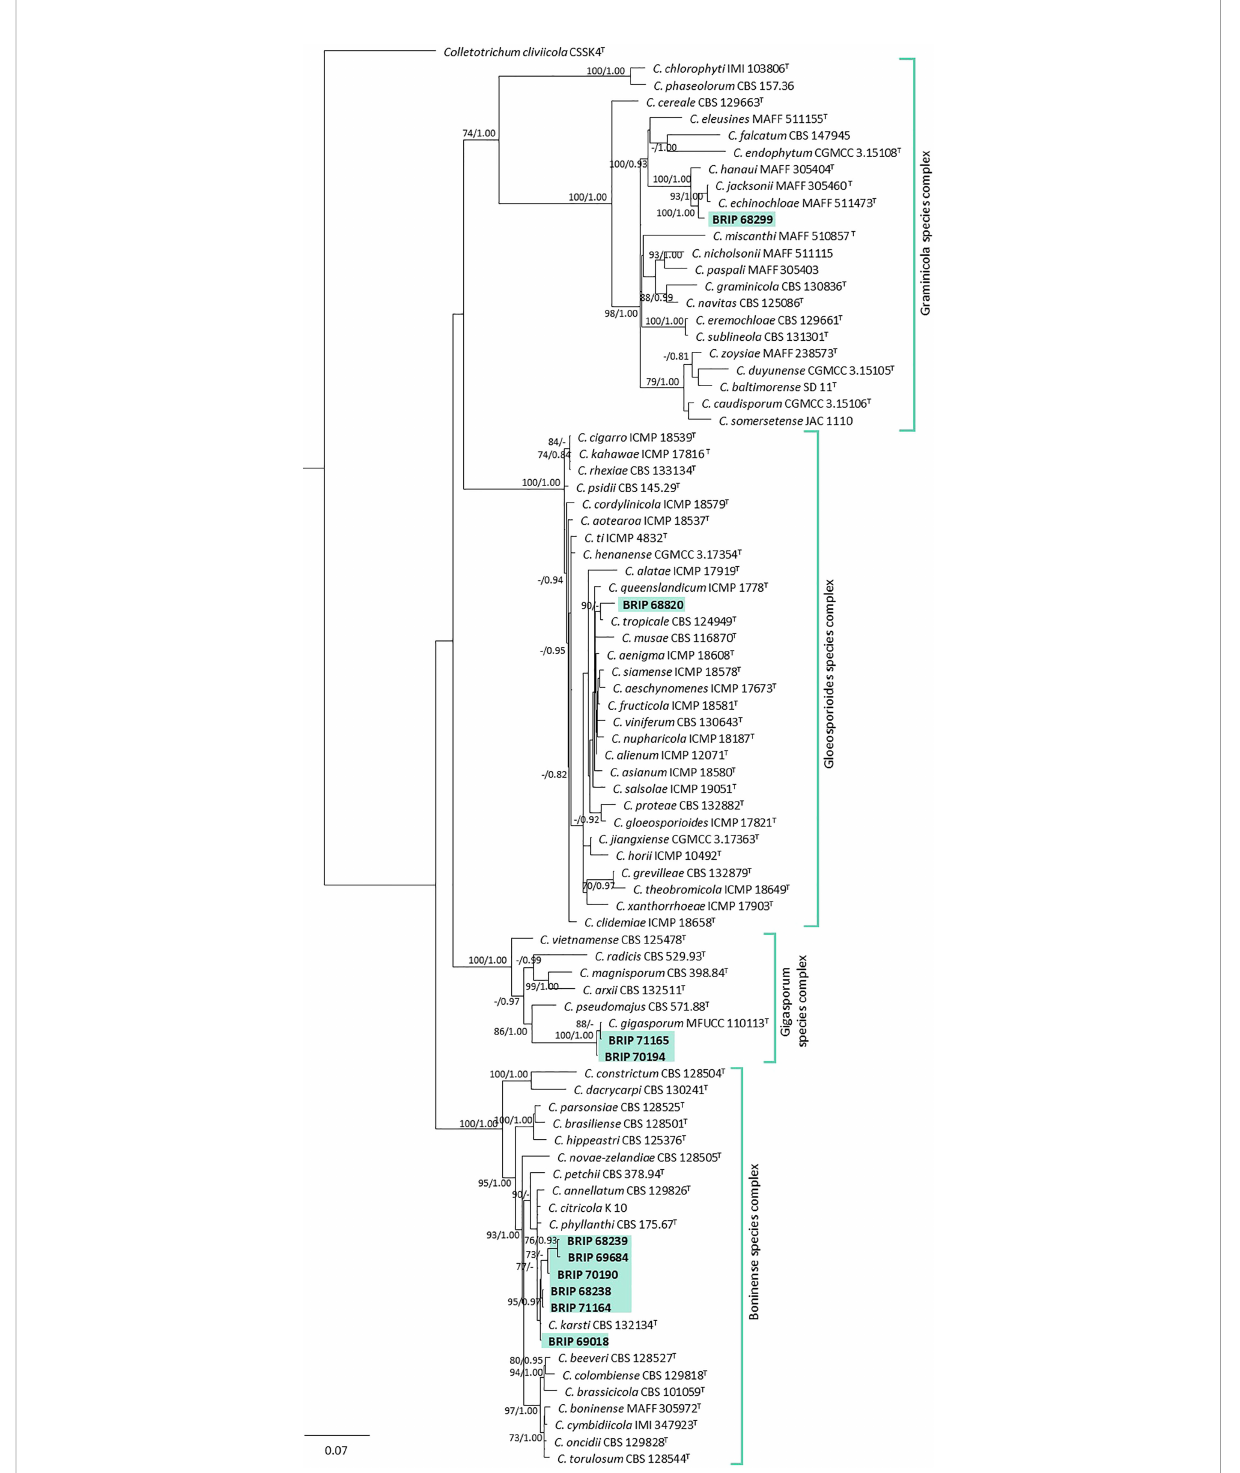
FIGURE 6 Phylogenetic tree inferred from a RAxML analysis based on a concatenated alignment of ITS, tub2 and gapdh sequences of related genera from the Colletotrichumgleosporioides , Co. graminicola , and Co. boninense species complexes in Glomerellaceae (Glomerellales). RAxML bootstrap (bs) values greater than 70% and Bayesian posterior probabilities (pp) greater than 0.8 are given at the nodes (bs/pp). In bold font are the isolates from this study, and ex-type strains are indicated by T